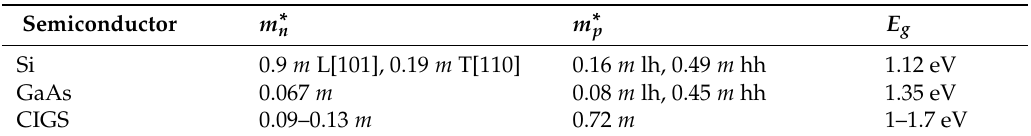
Table 2. Substrate material parameters to Formula (18) ( m = 9.1 × 10 − 31 kg, the mass of bare